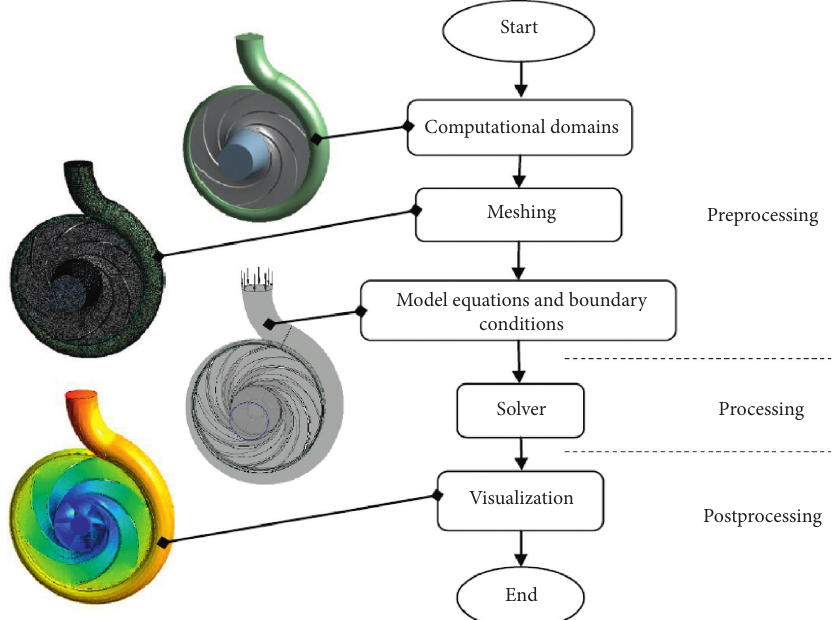
Figure 1: Flow chart of the simulation process.